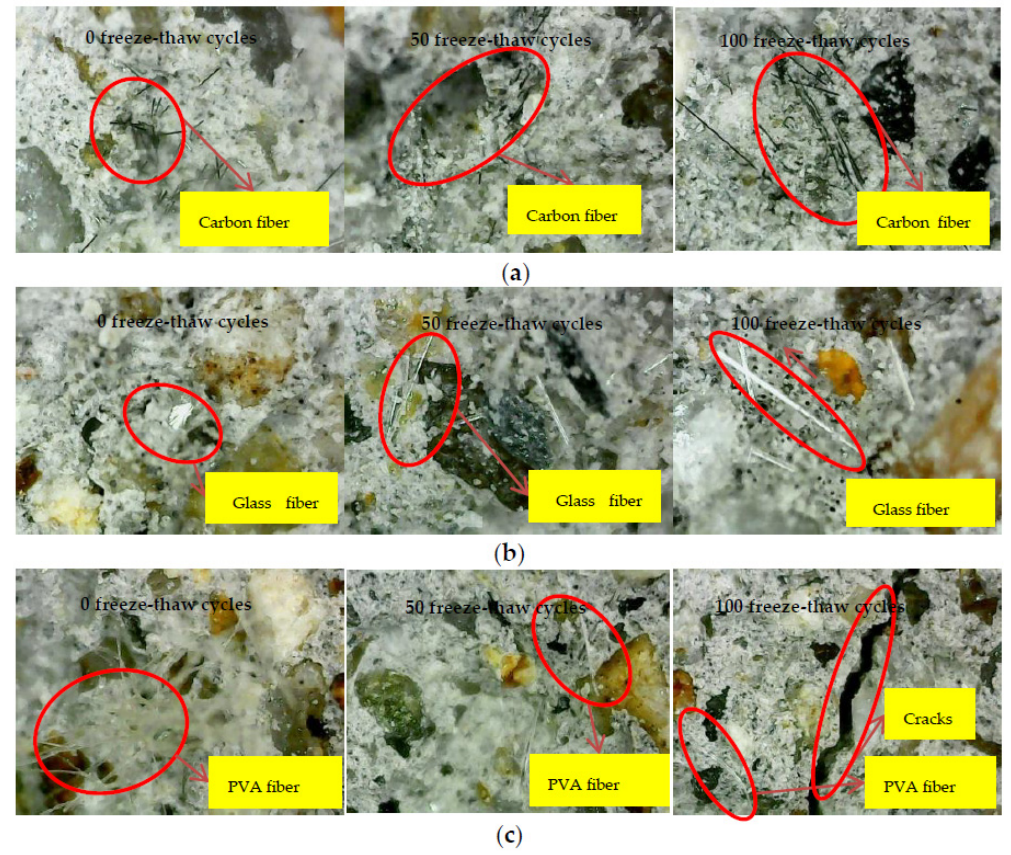
Figure 6. Microscopic observation: ( a ) Carbon fiber; ( b ) Glass fiber; ( c ) PVA